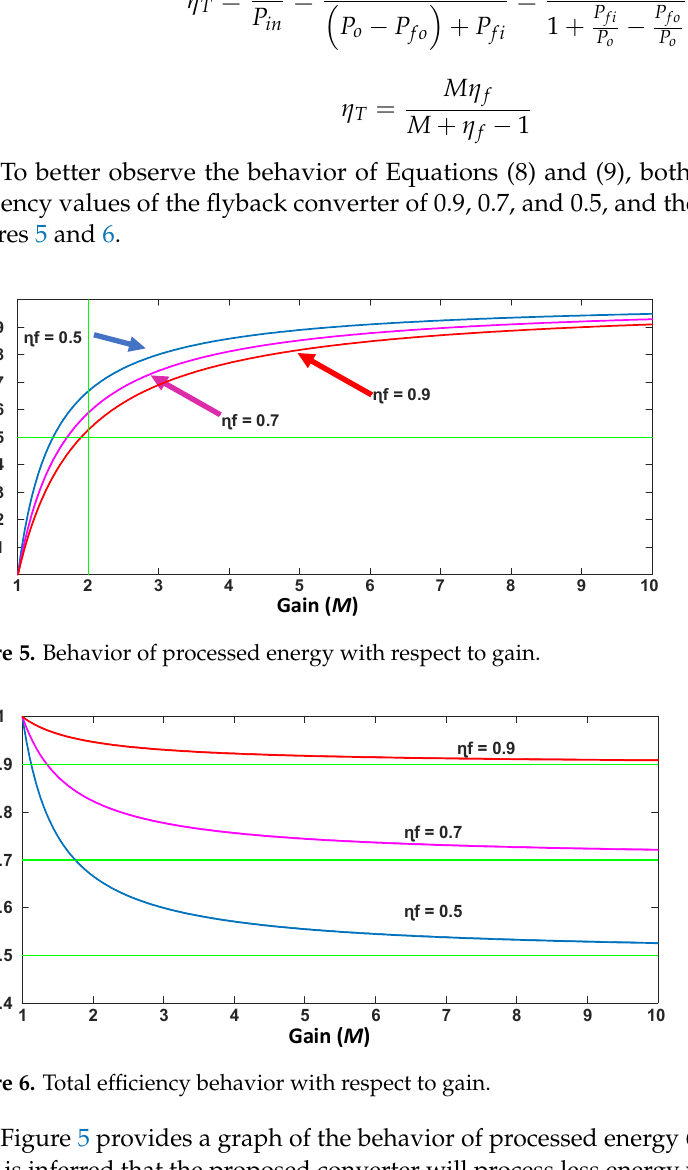
I o I in Figure 8. Equivalent circuit in low frequency averaged analysis.